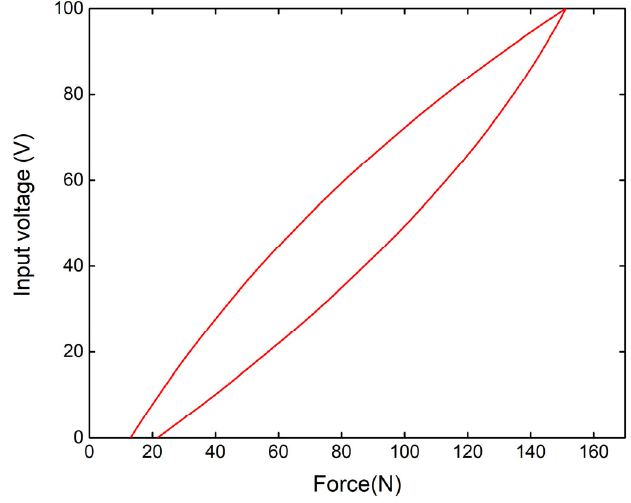
Figure 6. The inverted P ‐ I model.